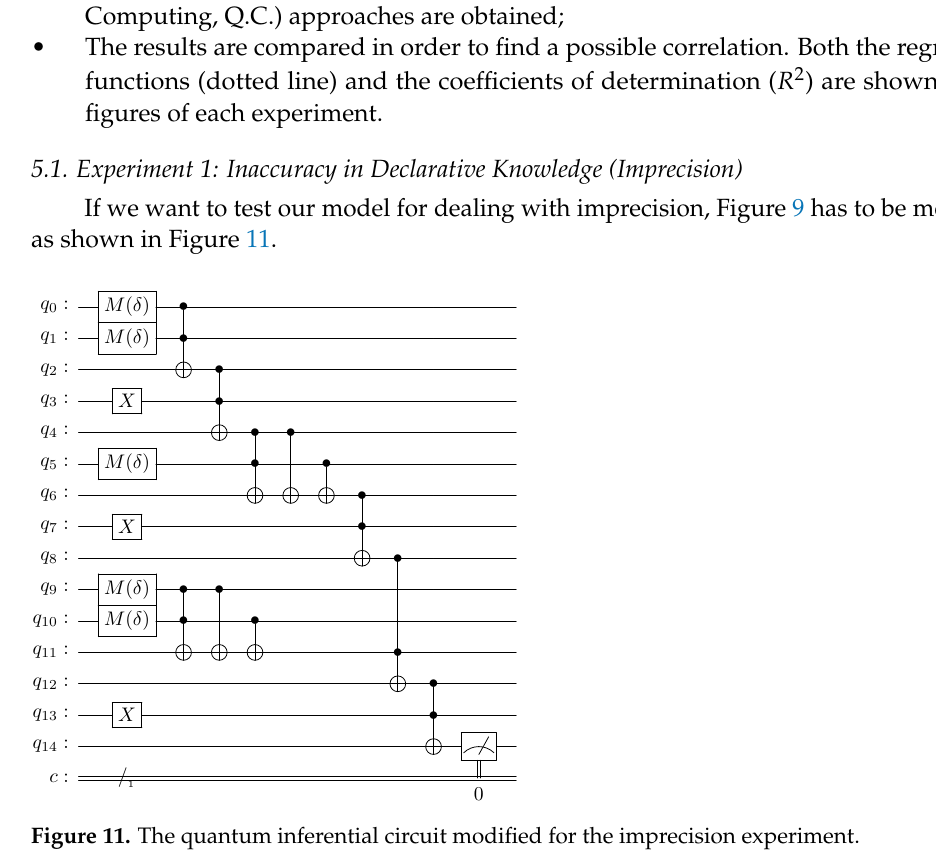
Figure 11. The quantum inferential circuit modified for the imprecision experiment. The Hadamard gates of quantum lines q 0 , q 1 , q 5 , q 9 , and q 10 were replaced by M ( δ ) gates, so as to configure inaccurate inputs. The Hadamard gates of quantum lines q 3 , q 7